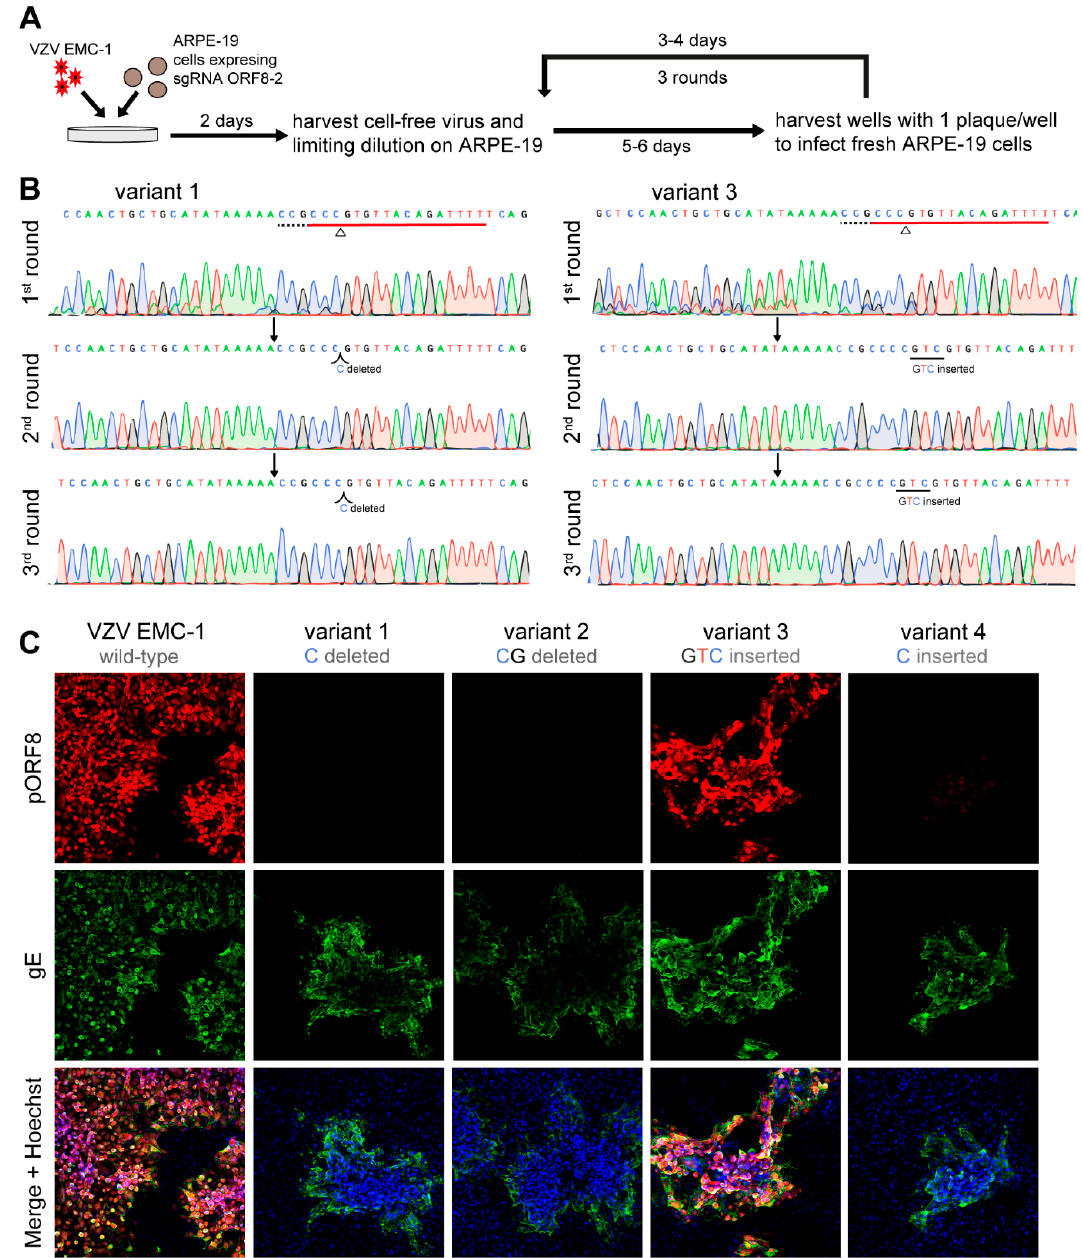
Figure 2. Plaque purification of VZV edited by gRNA ORF8-2. ( A ) Experimental design: Stably transduced ARPE-19 cells expressing sgRNA ORF8-2 were infected with VZV EMC-1. Two days post-infection, cell-free virus was harvested, and subjected to three subsequent rounds of plaque purification. ( B ) Sanger sequencing after each round of plaque purification for variant 1 and 3 showing the sgRNA target regions (red), PAM sequence (dashed black), cleavage site with triangle and identified mutation. ( C ) Representative images of ARPE-19 cells infected with VZV EMC-1 or 4 ORF8 variant viruses derived from sgRNA ORF8-2 cells by plaque purifications stained by immunofluorescence for glycoprotein E (green) and pORF8 (red). Nuclei were counterstained with Hoechst 33342 (blue), with 10× magnification.